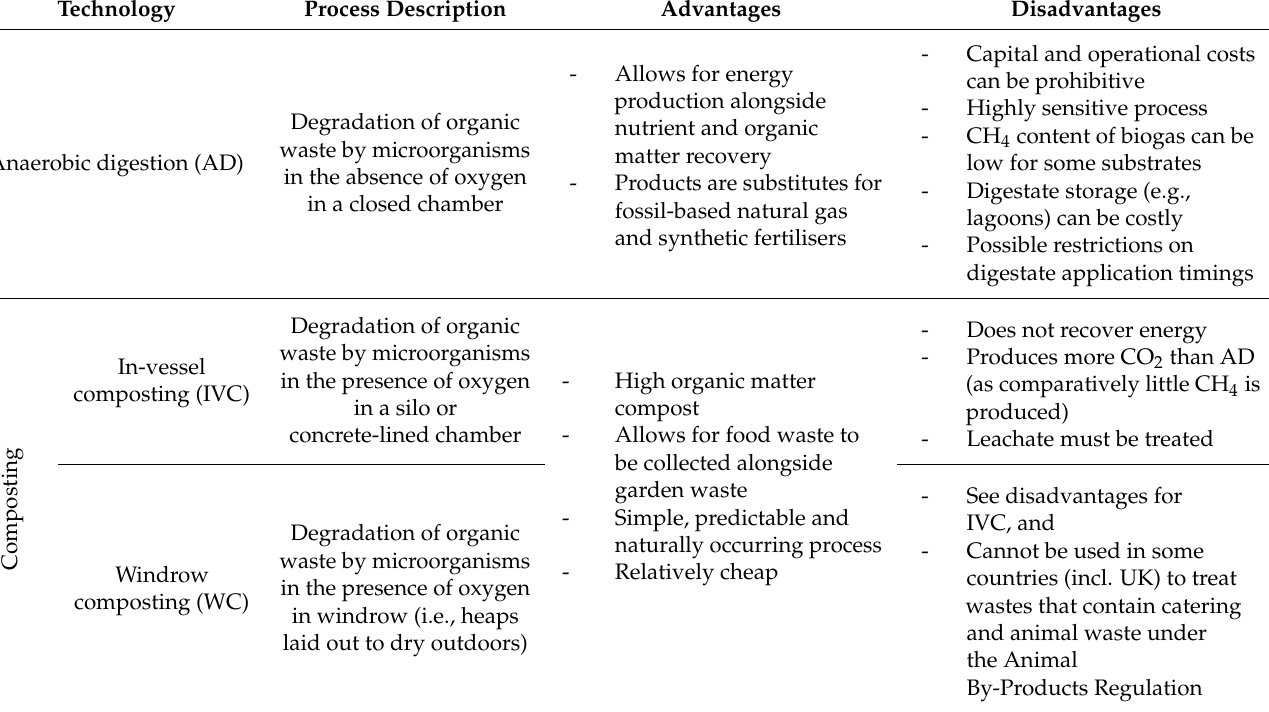
Table 3. Characteristics of various waste treatment strategies for separately collected organic